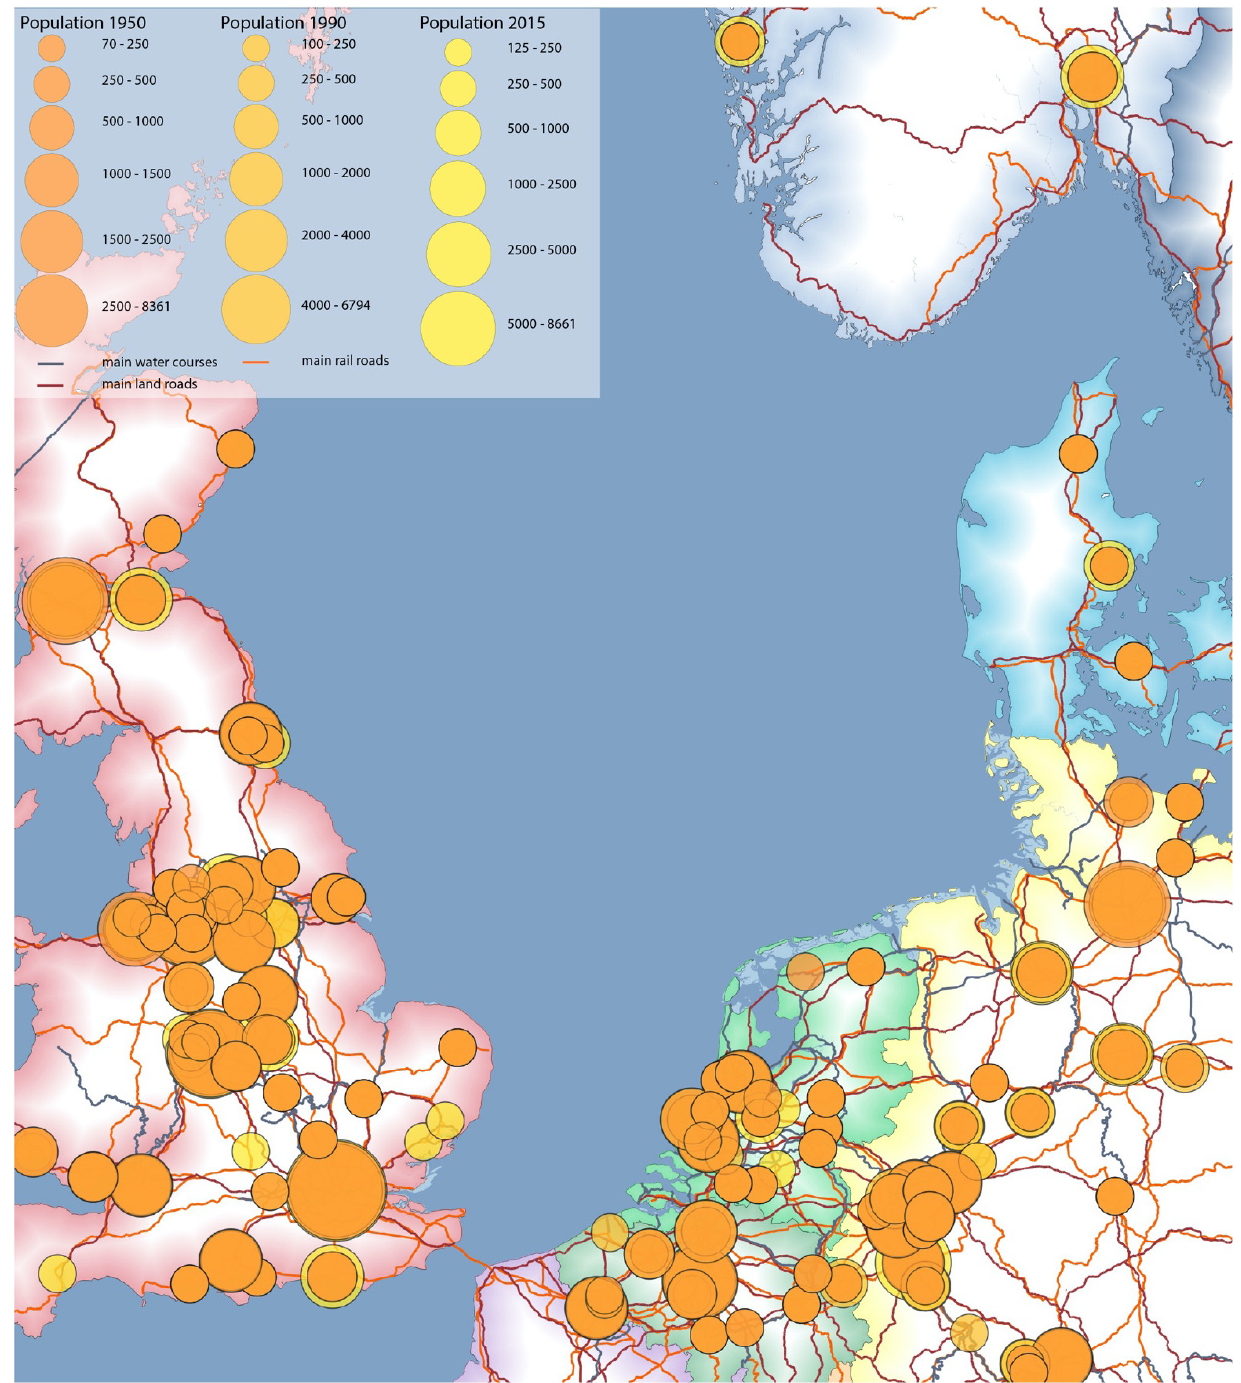
Figure 10. Cities around the North Sea area with the largest populations in 1950, 1990, and 2015, combined with political boundaries and infrastructure over land, rail, and water in 2015. Map: Yvonne van Mil. Source: van Mil and Rutte (2020a,